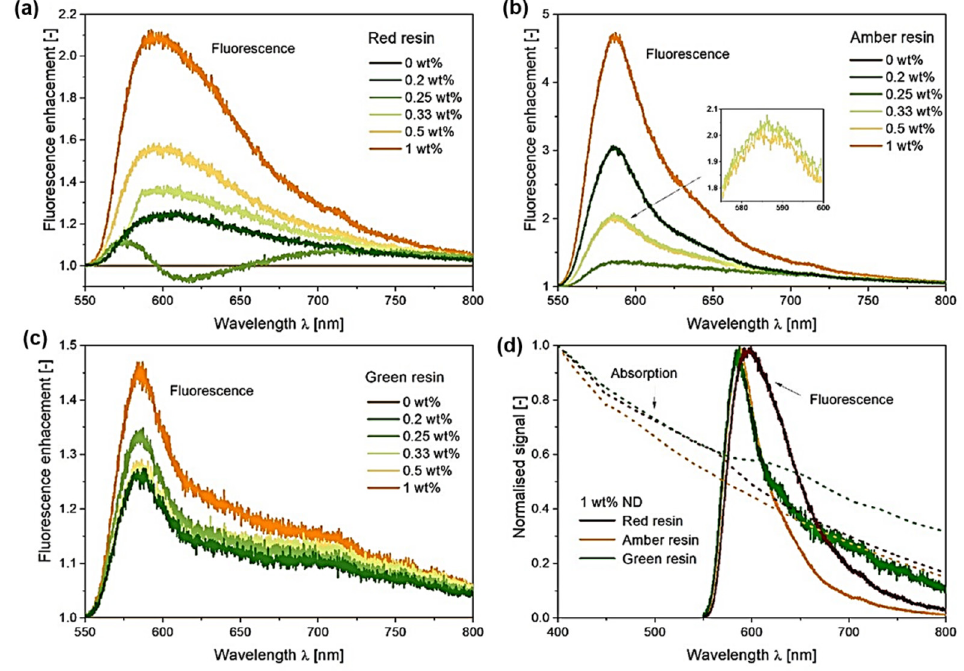
Figure 6 . Fluorescence enhancement of MDPs–polymer composites with amber resin ( a ), red resin ( b ), and green resin ( c ). Graph ( d ) shows normalized fluorescence and absorption signal for composites with 1 wt.% ND (0 wt.% in above figures belongs to the pure polymer without MDPs).